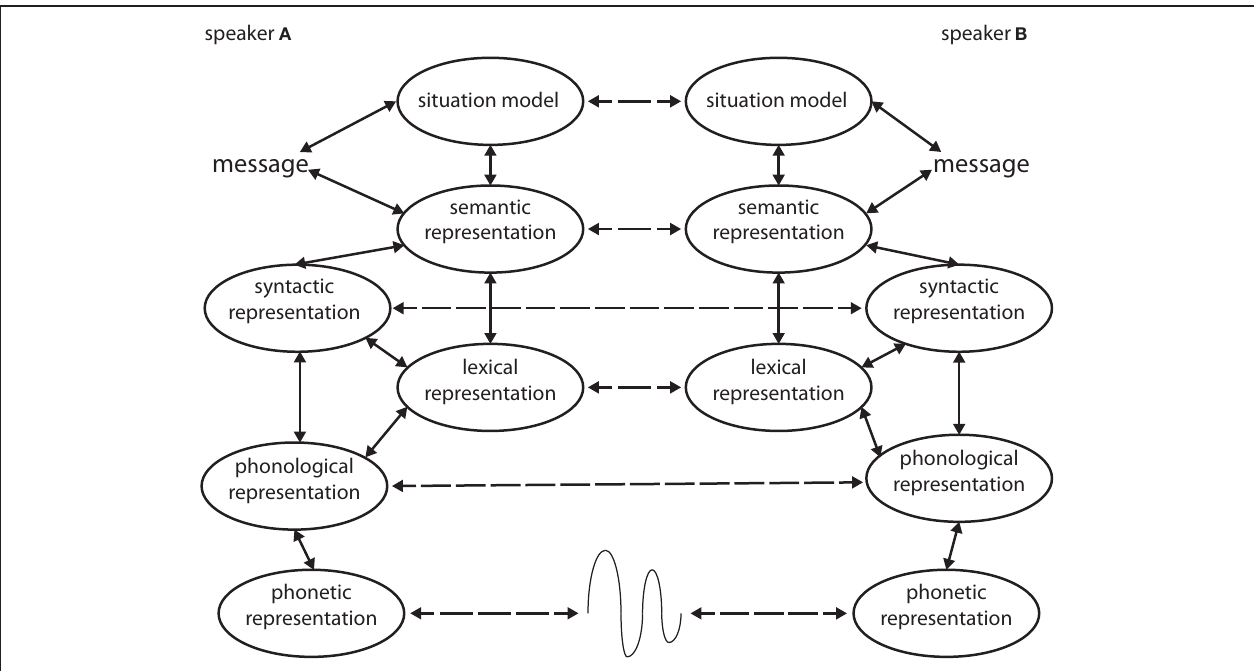
FIGURE 1 | The interactive-alignment model (based on Pickering and Garrod, 2004). Speakers A and B represent two interlocutors in a dialogue in this schematic representation of the stages of comprehension and production according to the model. The dashed lines represent alignment